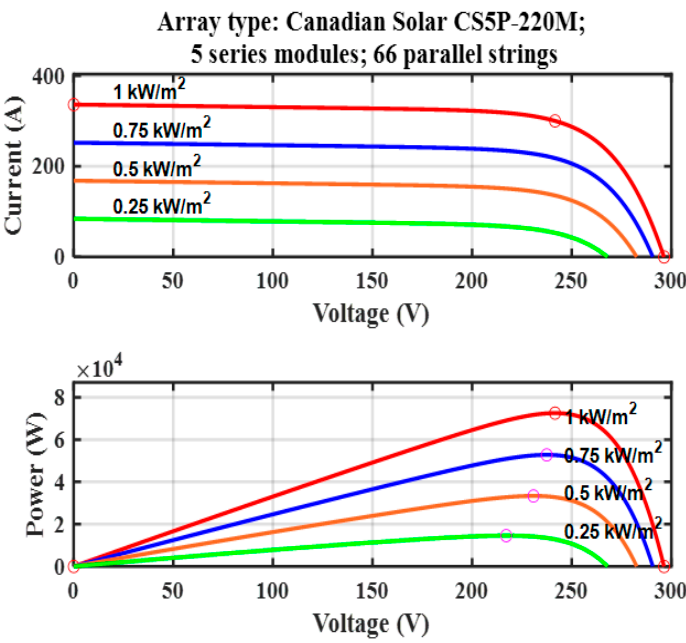
Figure 4. Specifications of a PV array at 25 °C.